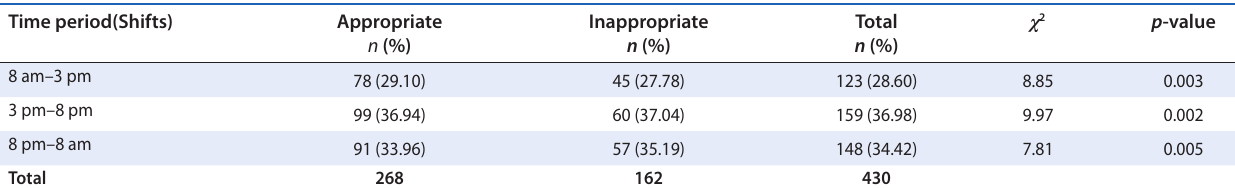
Table 2: Pattern of clinical presentations of non-urgent and urgent cases over different work